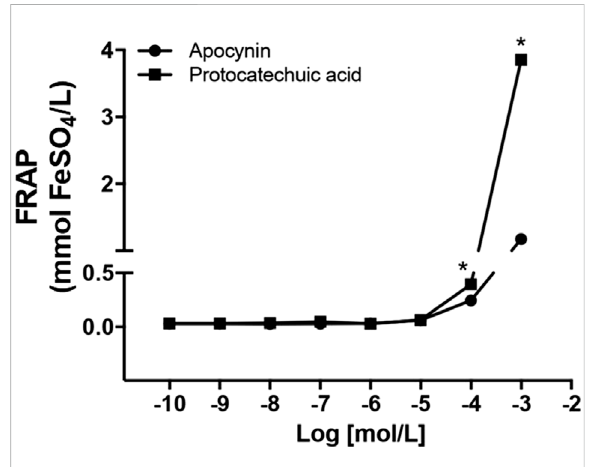
FIGURE 2 Antioxidant capacity, in mmol FeSO 4 /L, of apocynin (circles) andprotocatechuicacid(squares),atconcentrationsof0.1 nmol/L to 1 mmol/L * p < 0.05 Protocatechuic acid vs. Apocynin.